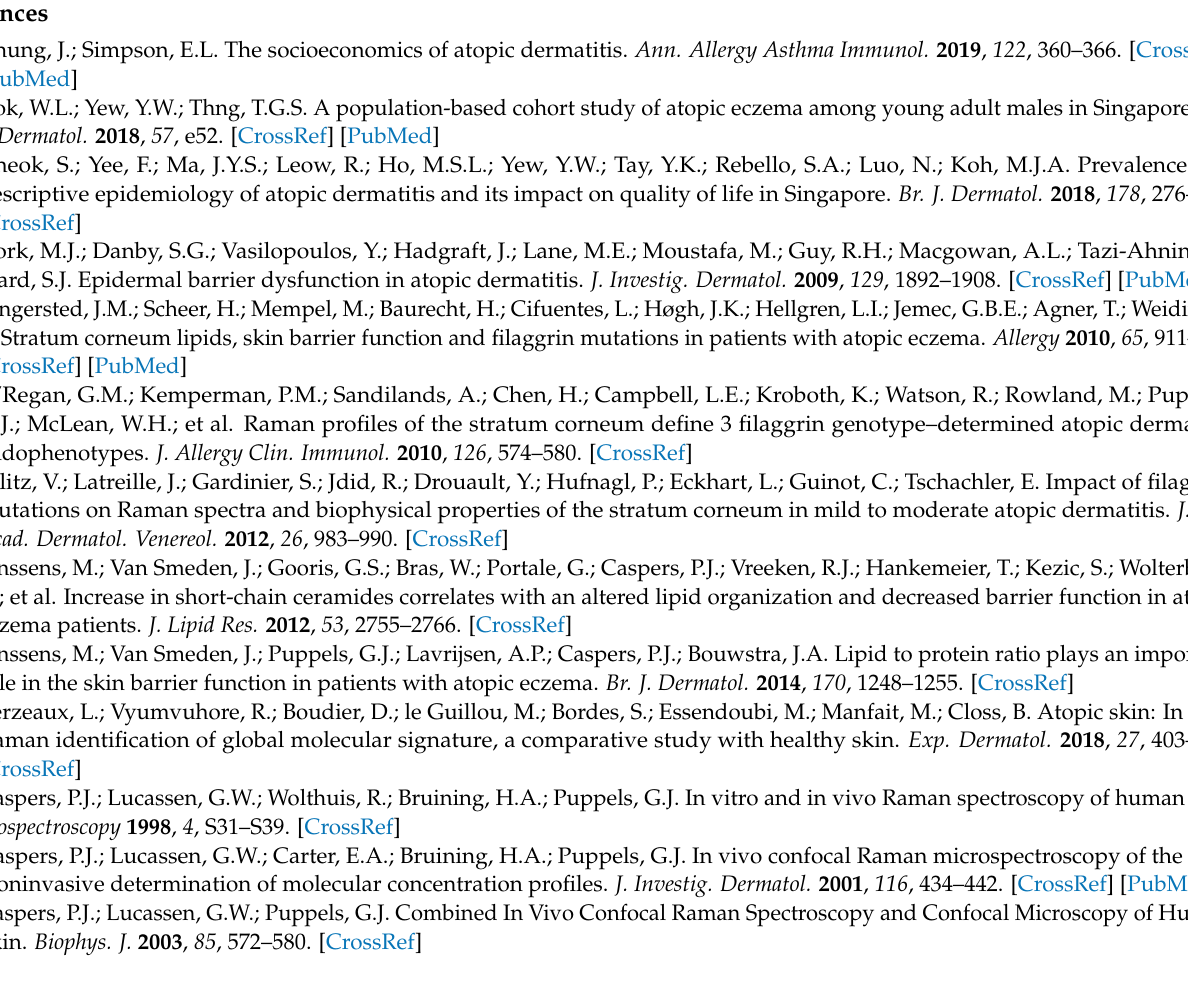
Figure A2. Skin Raman spectra acquired at 10 depths. The skin surface (highlighted) was evaluated by finding Raman spectra maximum peak intensity related to amide I (Keratin) 1655 cm − 1 .